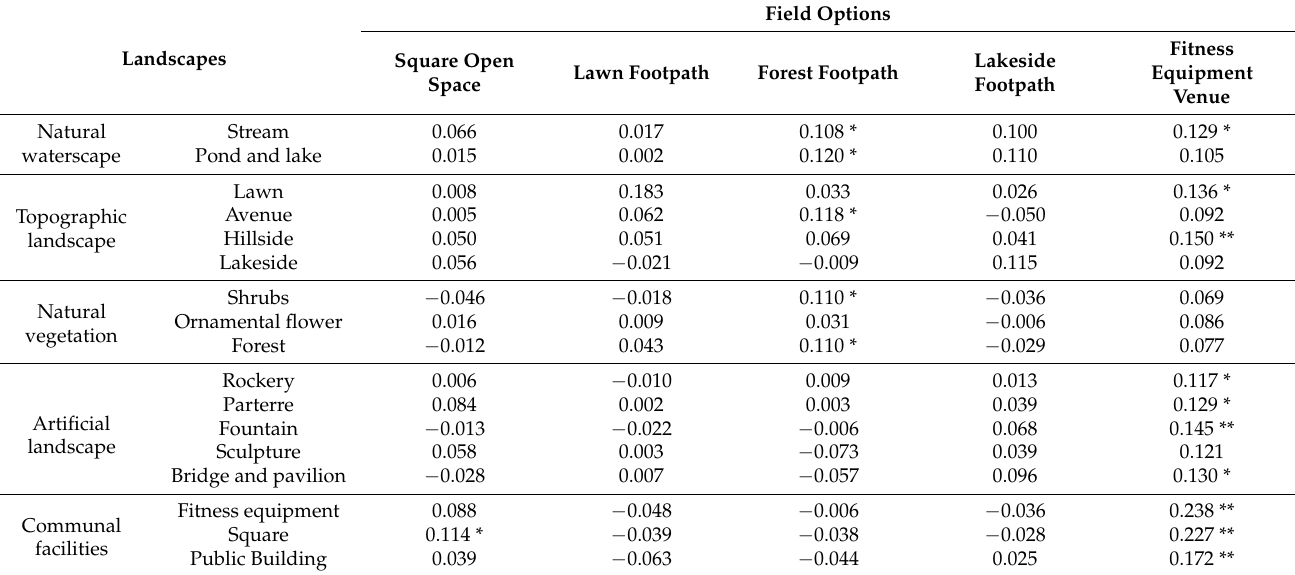
Table 5. Correlation between different exercise site selections and visual landscape